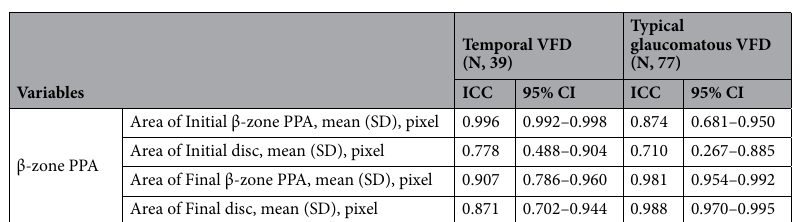
Typical glaucomatous VFD (N, 77)